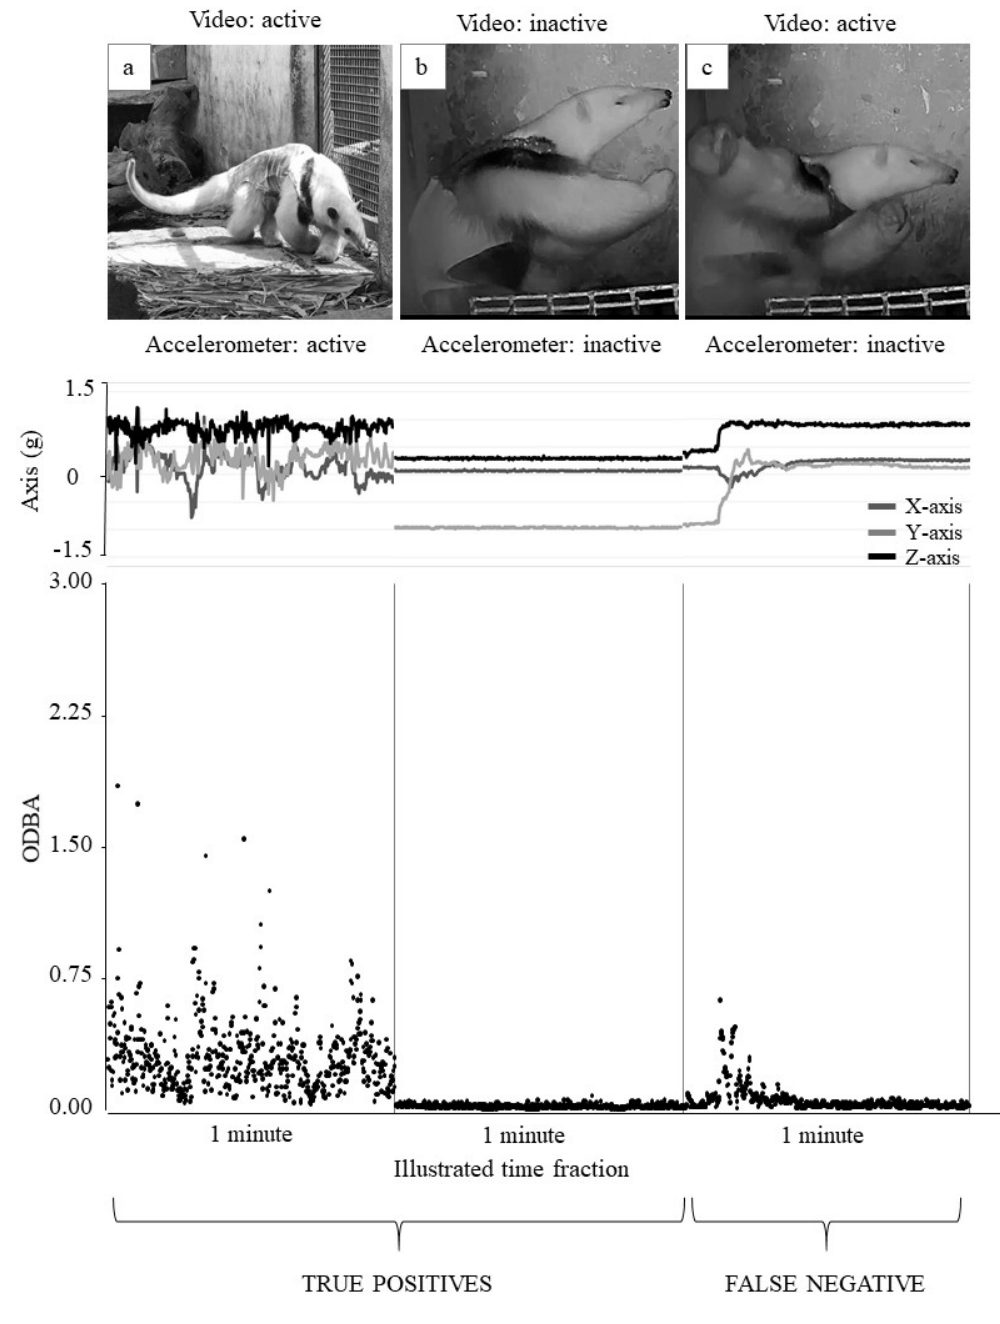
Figure 8. Comparison of a fraction of behavioural events observed using video recordings and predicted using an accelerometer. Data are from the 24 h pilot test carried out on an adult Tamandua tetradactyla . In the upper part, images show a frame of 1 min of video recordings. Images a and c show a lesser anteater that was active (locomotion and others), and image b shows an inactive state of the same animal (rest). In the middle part, X, Y, and Z profiles are shown for the same fractions of the video. In the lower part, detected ODBA variance values obtained from accelerometer monitoring for each behavioural event are illustrated. According to activity threshold value (0.0055), a was classified as active (true positive) and b and c as inactive (true positive and false negative,